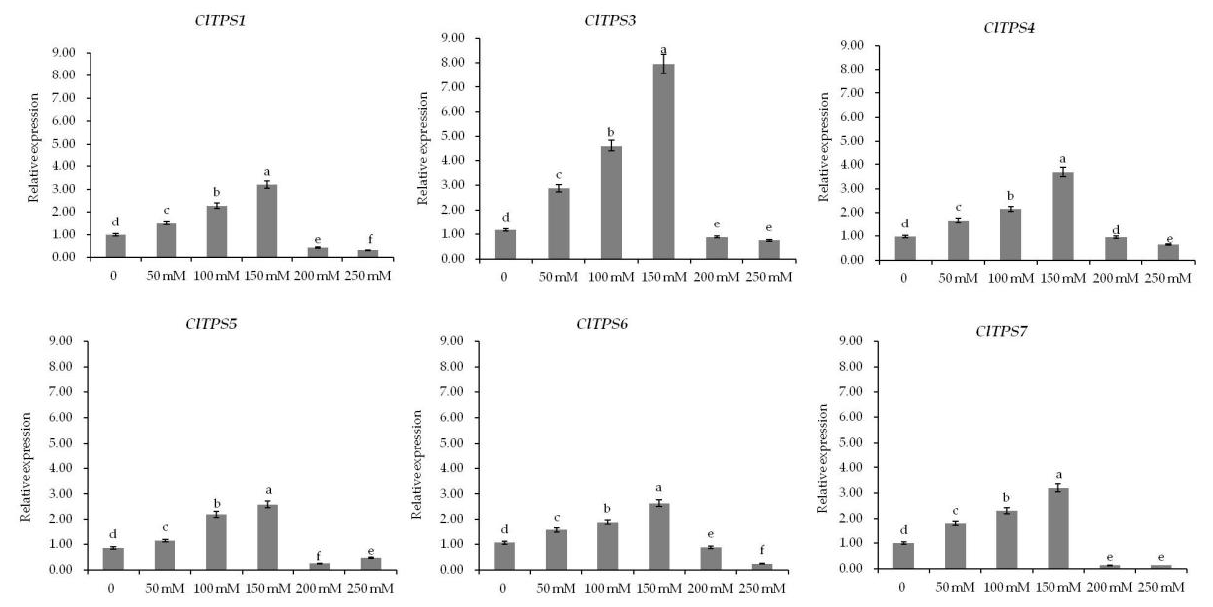
Figure 6. Expression analysis of ClTPSs under different NaCl concentrations. ClTPS2 expression was not detected. Error bars indicate the SD of three biological replicates. Different letters indicate significant differences within treatments by ANOVA ( p < 0.05).